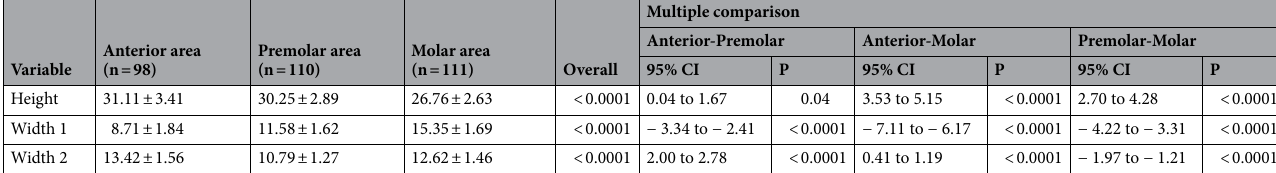
Table 4. The height and width of each section of the